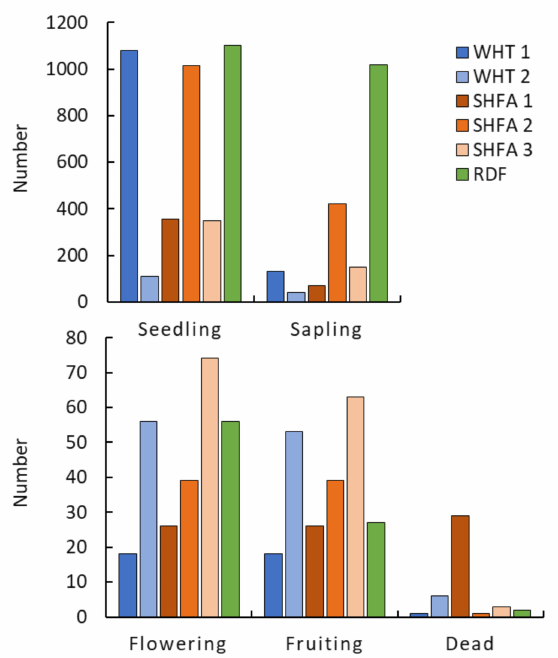
Figure 2. Distribution of Nicotiana glauca shrubs by growth stages in different locations in the Taif region, Saudi Arabia. WHT: Alwaht, RDF: Ar-Ruddaf, SHFA: